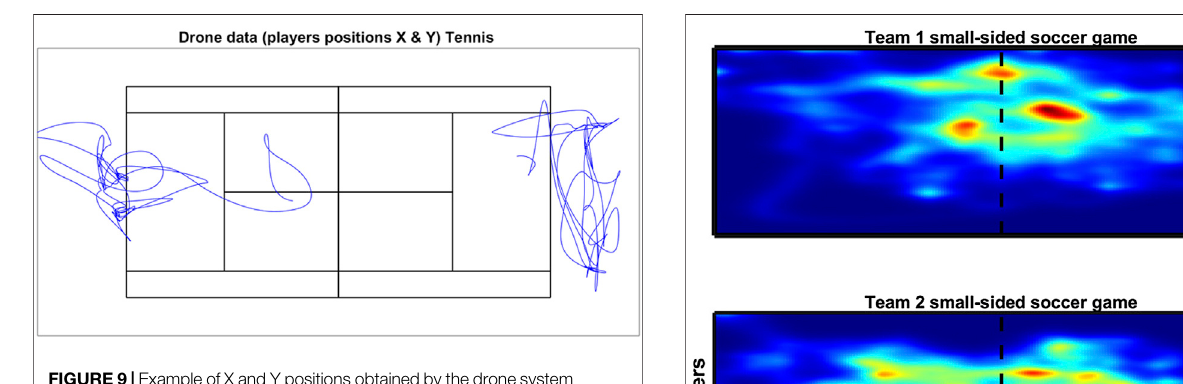
FIGURE 9 | Example of X and Y positions obtained by the drone system for two players during 1-min of gameplay in a tennis match.